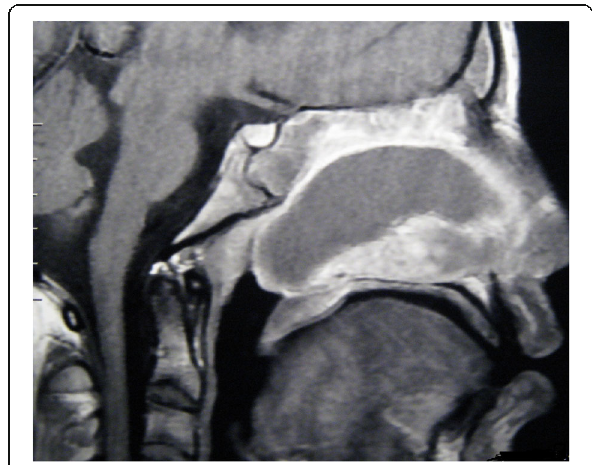
Fig. 4 Sagittal MRI with contrast (T1 sequences) of the paranasal sinuses showing a huge lesion with hypointense core with enhanced margins extending to the nasopharynx